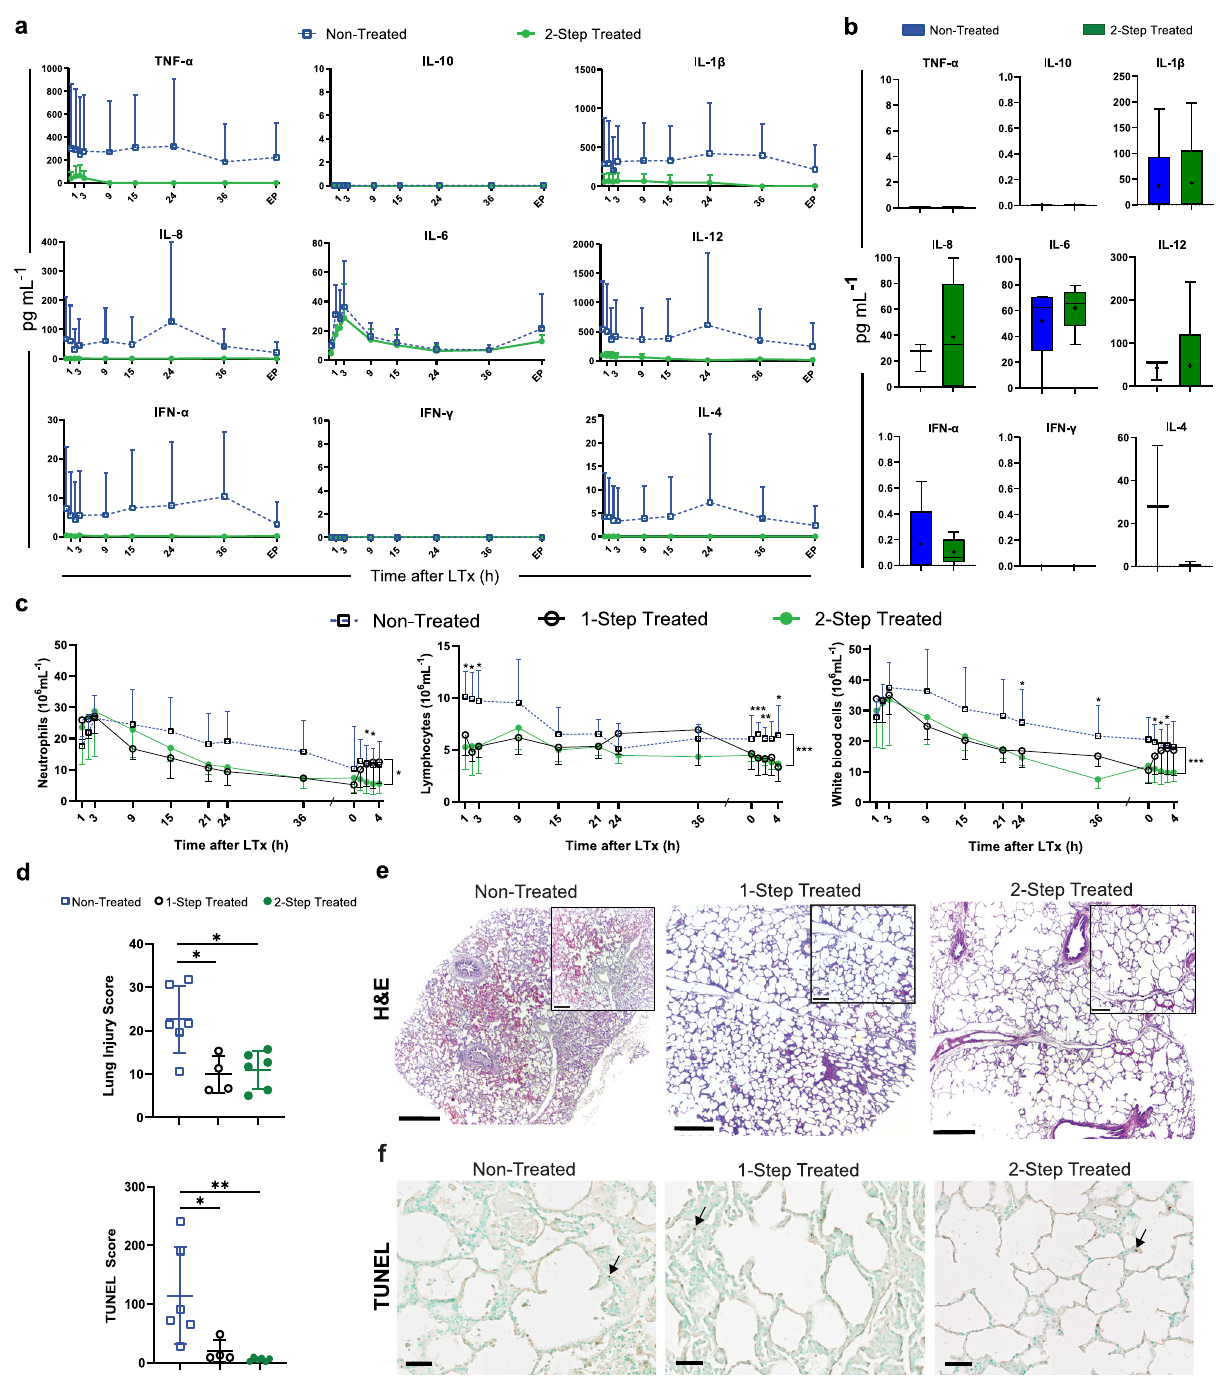
Fig. 4 Reduced in fl ammatory state during lung transplantation (LTx) and follow-up. a Plasma cytokine levels were monitored throughout the 48-hour period following transplantation, with 1 h marking the time elapsed since the start of treatment. EP stands for endpoint of the experimental timeline. b Bronchoalveolar lavage fl uid (BALF) was tested for cytokine concentrations at the termination of the experiment represented as a box-and-whiskers plot with a median line, a plus at the mean, and minimum and maximum values. c Cell counts including neutrophils, lymphocytes, and white blood cells were analyzed. Statistical signi fi cance applies to direct comparison of two-step treatment to the non-treated group. d Scoring of the lung injury across groups (top) and scoring of the terminal deoxynucleotidyl transferase dUTP nick end labeling (TUNEL) cell counts per mm 2 (bottom). e Hematoxylin and eosin (H&E) staining representative of n = 16 of non-treated (left), one-step treated (middle) and two-step treated (right) biopsies taken at the end, following 4 h of isolated transplanted lung function. f Representative images of n = 5 lungs of TUNEL staining in non-treated (left), one-step treated (middle) and two- step treated lungs (right) with representative black arrows indicating positively stained cells used in the TUNEL score. Scale bars represent 50 µ m, respectively. All graphs represent data from either the two-step treated recipient lungs ( n = 6), the one-step treated recipients ( n = 4) or non-treated lungs ( n = 6). Statistically signi fi cant differences between groups were tested with two-sided Student ’ s T -test and within groups with ANOVA when data were normally distributed. The two-sided Mann – Whitney test and the Kruskal – Wallis test were used when data were not normally distributed. * p < 0.05, ** p < 0.01, *** p < 0.001. All values represent the mean ± standard deviation unless otherwise stated. NATURE COMMUNICATIONS| (2022) 13:4173 |https://doi.org/10.1038/s41467-022-31811-5|www.nature.com/naturecommunications